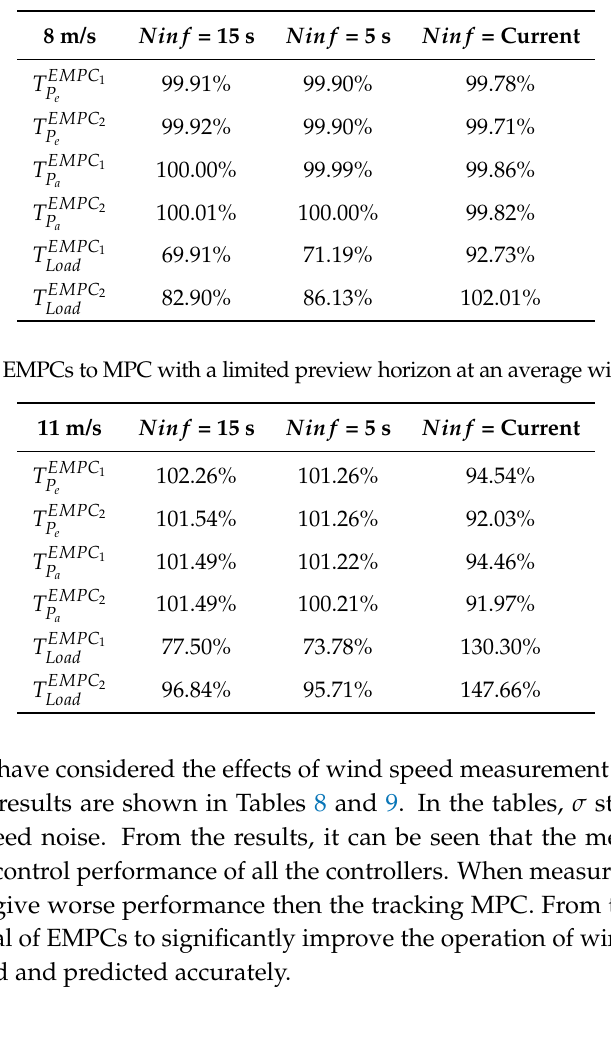
Table 6. The rate of EMPCs to MPC with a limited preview horizon at an average wind speed of 8 m/s. 8 m/s Ninf = 15 s Ninf = 5 s Ninf = Current T EMPC 1 99.91% P e